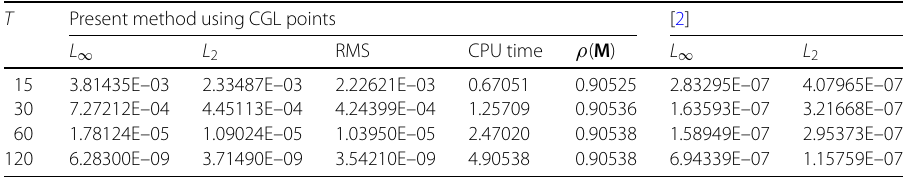
Table 2 Error norms and spectral radius for the solution of Example 1 in Case 1.2